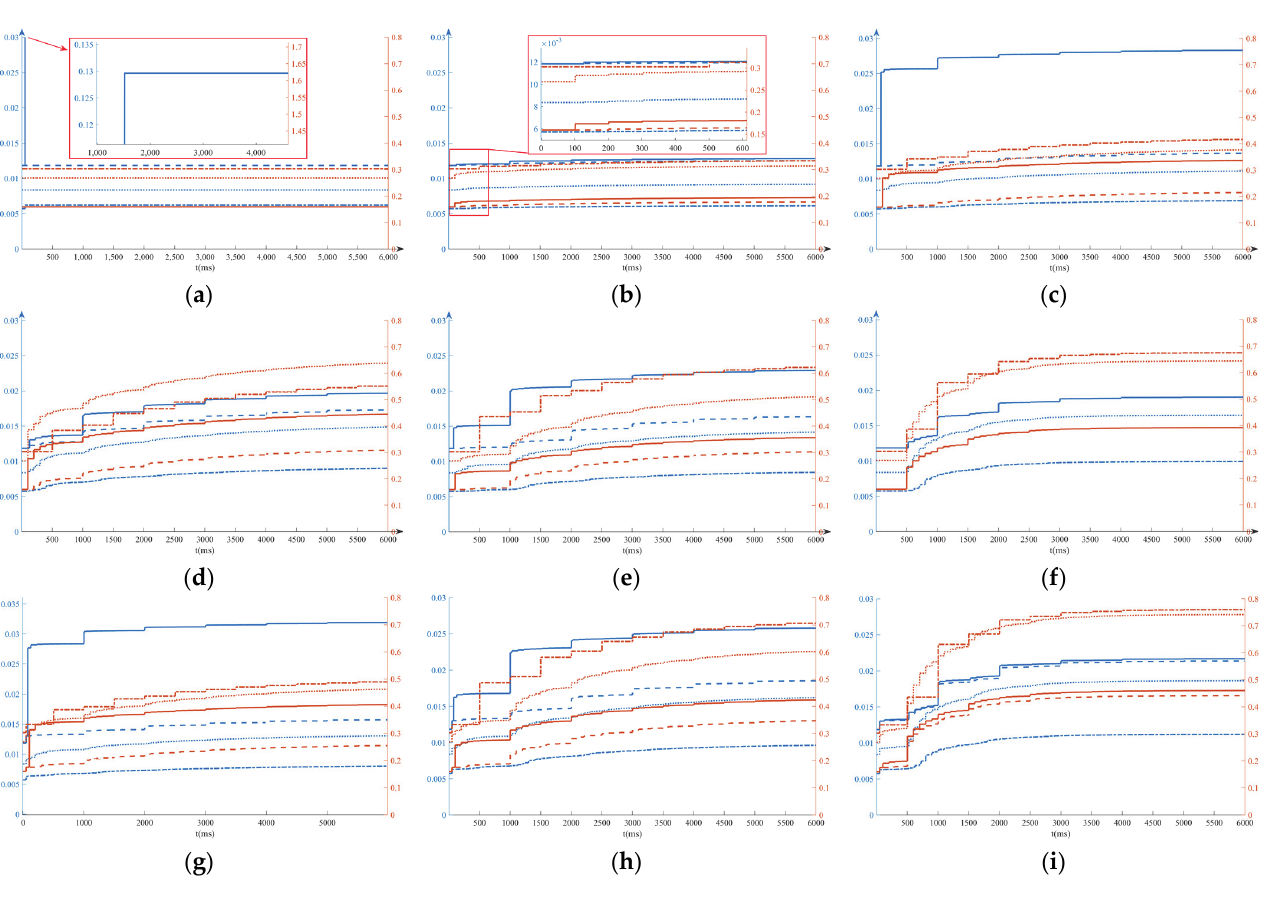
Table 6. Record table of critical time probability of multi-type attacks (unit: %).